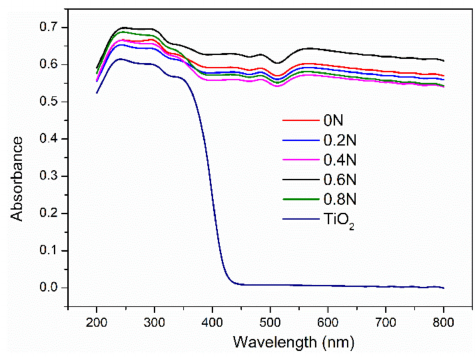
Figure 4. UV-vis di ff use reflectance